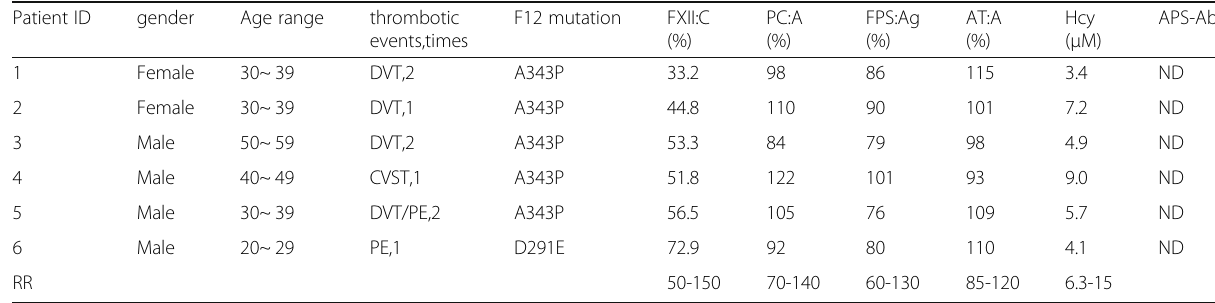
Table 1 Summary of F12 mutations and clinical presentation of patients with venous thrombosis